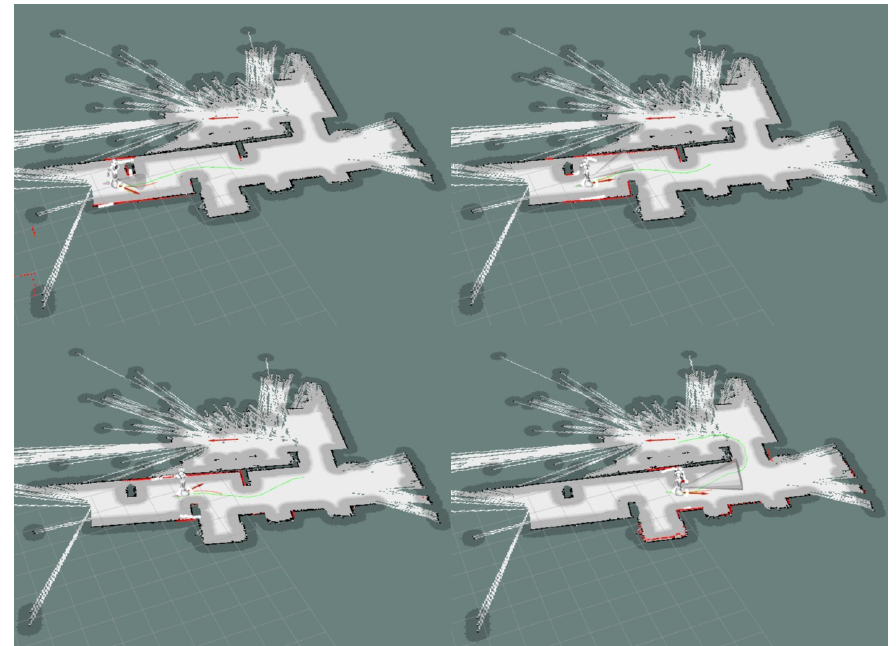
Figure 14. Global planner results for the larger scale experiment with obstacles on the hallway.